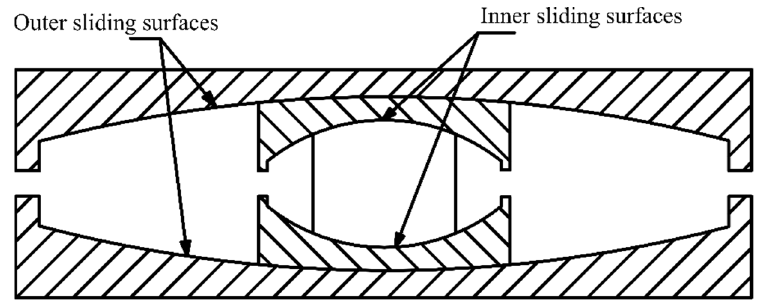
Figure 5. Schematics of a triple pendulum friction bearing.